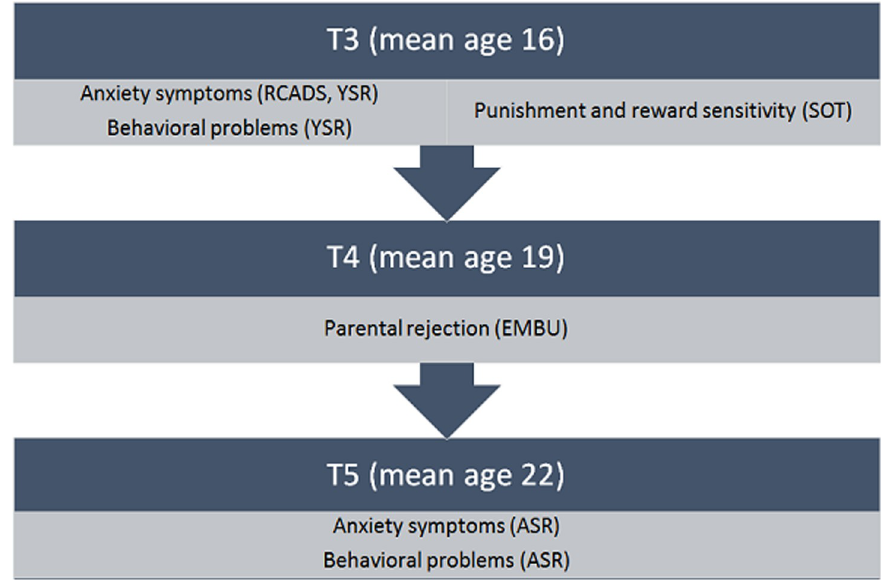
Fig 1. Timeline and measures. Note . Revised Child Anxiety and Depression Scale-Child (RCADS), Youth Self Report (YSR), Spatial Orientation Task (SOT), Egna Minnen Betra¨ffande Uppfostran (EMBU), Adult Self Report (ASR).